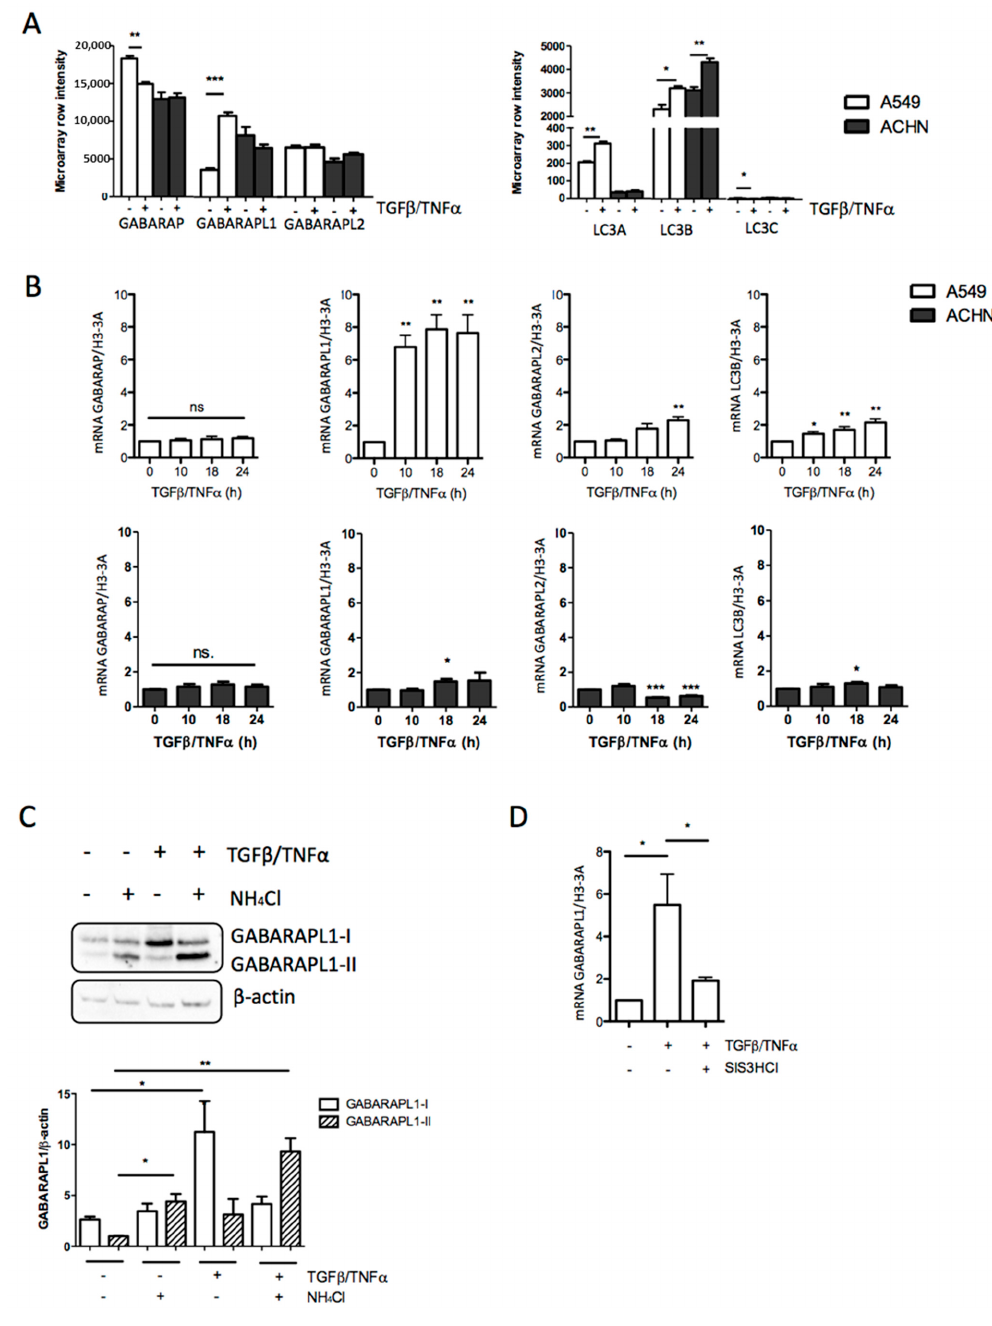
Figure 2. GABARAPL1 expression is increased during TGF- β /TNF- α -induced EMT. ( A ) Transcriptome analysis of ATG8 gene expression. ATG8 gene expression was quantified by microarray in A549 and ACHN cells untreated or treated with TGF- β (5 ng/mL) and TNF- α (20 ng/mL) for 5 days [26]. ( B ) mRNA levels of GABARAP, GABARAPL1, GABARAPL2, and LC3B were measured by qRT-PCR over the course of 0, 10, 18, and 24 h of TGF- β (5 ng/mL)/TNF- α (20 ng/mL)-induced EMT in A549 cells. The values calculated by the ∆∆ CT method are relative to the levels of H3-3A, and are expressed as fold change. ( C ) Western blot analysis of GABARAPL1 levels in A549c cells untreated or treated with 50 mM NH 4 Cl for 2 h in the presence or absence of TGF- β 5 ng/mL and TNF- α 20 ng/mL for 24 h. β -actin was used as a loading control. Protein levels were quantified using Image Lab. ( D ) mRNA levels of GABARAPL1 were measured by qRT-PCR in A549c cells. Cells were pretreated or not by the inhibitor of SMAD3 phosphorylation, SIS3HCl (10 µ M), for 6 h before induction of EMT by TGF- β (5 ng/mL)/TNF- α (20 ng/mL) for 24 h. The values calculated by the ∆∆ CT method are relative to the levels of H3-3A, and are expressed as fold